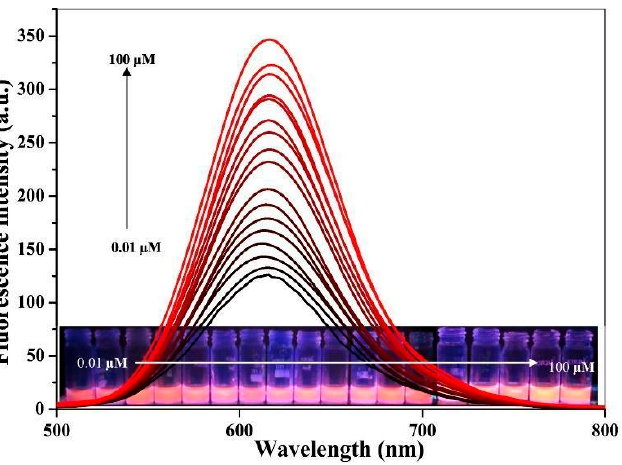
Figure 3. Fluorescence emission response of CE/11-MUA-AuNCs upon addition of Cd(II) in the range 0.01–100 μ M. (Adapted from reference [67] with permission from Elsevier).